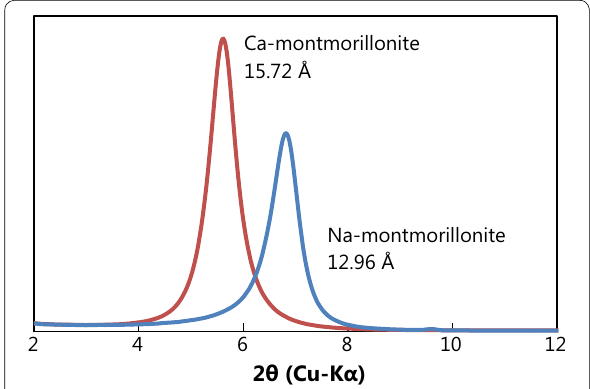
Fig. 1 XRD profile of Na- and Ca-montmorillonite at room tempera- ture and humidity with calculated each basal